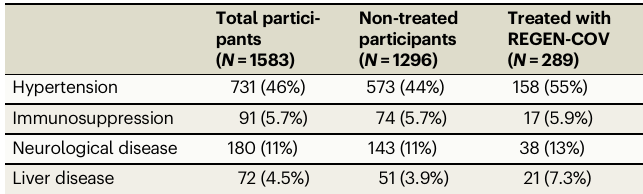
Table 1 | Baseline characteristics of the study population, by REGEN-COV